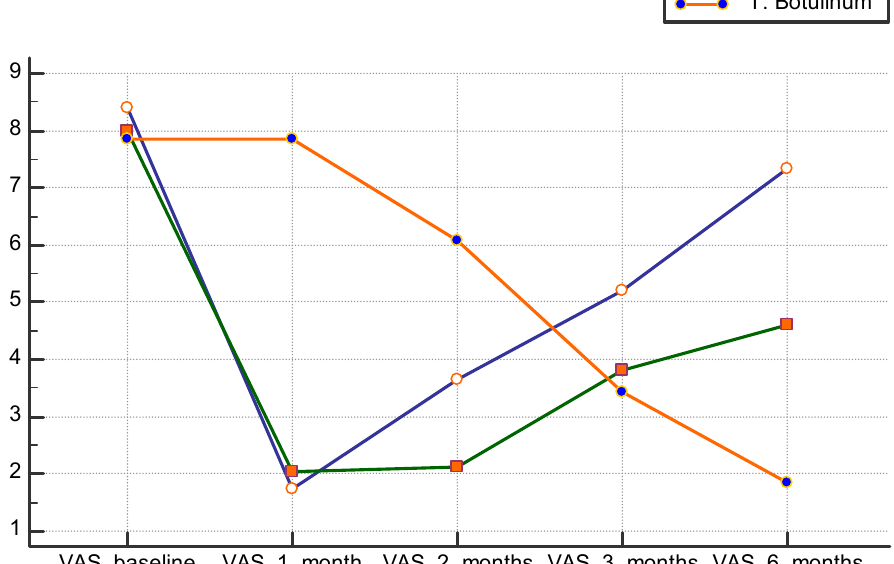
Figure 2. Post-injection comparison between the three studied groups as regards VAS score. VAS: visual analog scale. T. botulinum: botulinum toxin.